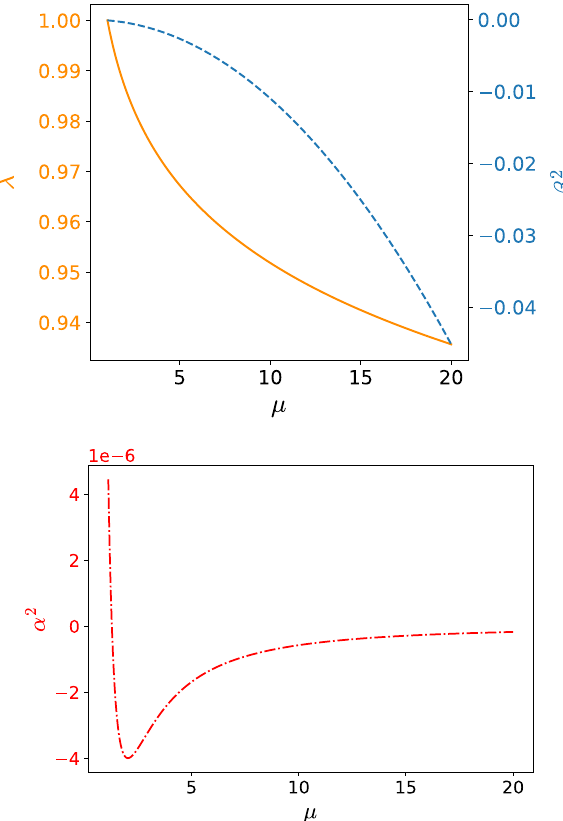
Fig. 3 Numerical solutions for the running of λ (continous and orange curve), β 2 (dashed and blue curve) and α 2 (dashed- dotted and red curve). The initial conditions correspond to (cid:11) (cid:10) v = (top panel) and v 4 = (cid:10) 1 , 10 2 , 10 − 5 , − 10 − 4 , 10 − 1 (cid:11) 3 1 , 10 , 10 − 5 , − 10 − 1 , 10 − 1 (bottom panel), choosing the initial energy μ 0 = 1 (all the quantities are measured in the corresponding powers of